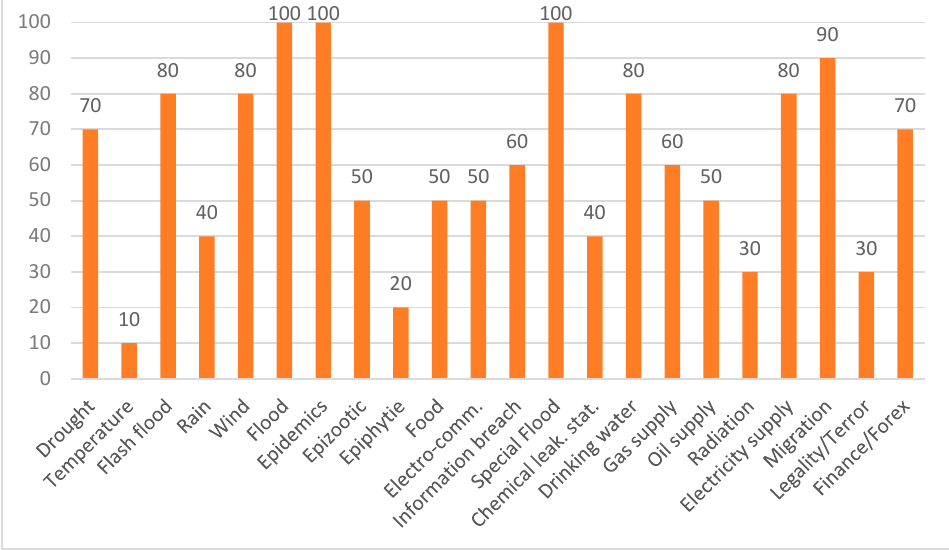
Figure 7. Existence of clear methodologies for different types of crisis situations.